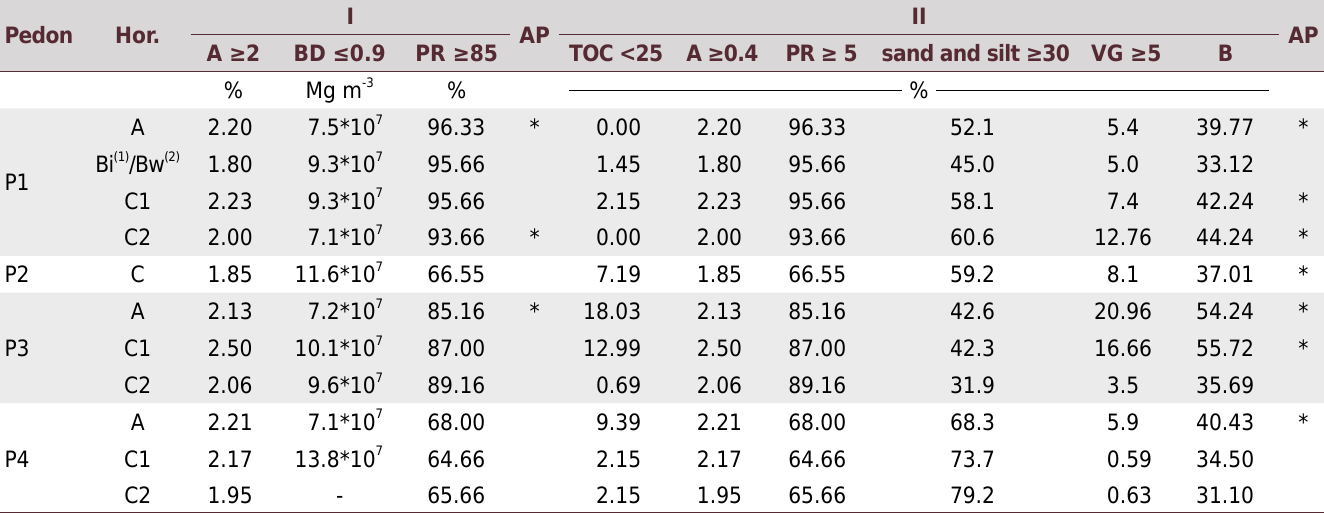
Table 5. Diagnostic criteria to andic properties according to (I) Soil Taxonomy (Soil Survey Staff, 2014) for moderately weathered soils, IUSS Working Group WRB (2015), and SiBCS (Santos et al., 2018), and (II) Soil Taxonomy for weakly weathered soils Pedon